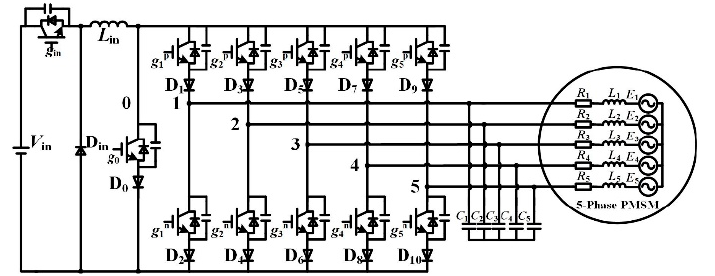
Figure 1. The topology of the five-phase current source driver.